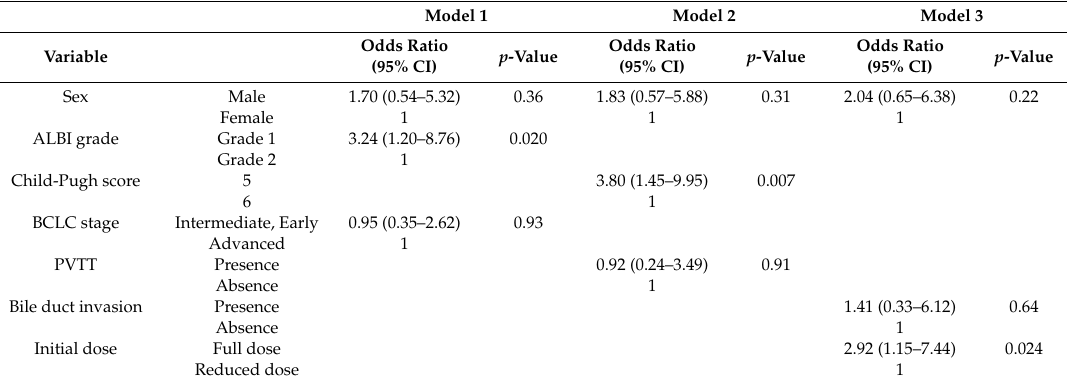
Figure 7. Among 79 patients with PS 0-1 who terminated lenvatinib treatment at the time of analysis, there were 36 patients (45.6%) who fulfilled the criteria for candidate for post-progression treatment such as regorafenib and cabozantinib (patients with preserved PS and liver function) and 11 patients (13.9%) who the criteria for candidate for ramucirumab treatment (patients with preserved PS, liver function and serum level of α -fetoprotein ≧ 400 ng/ml). HCC: hepatocellular carcinoma, PS: performance status. Table 6. Results of a multivariate analysis of factors associated with candidacy for post-progression treatment ( n = 79).